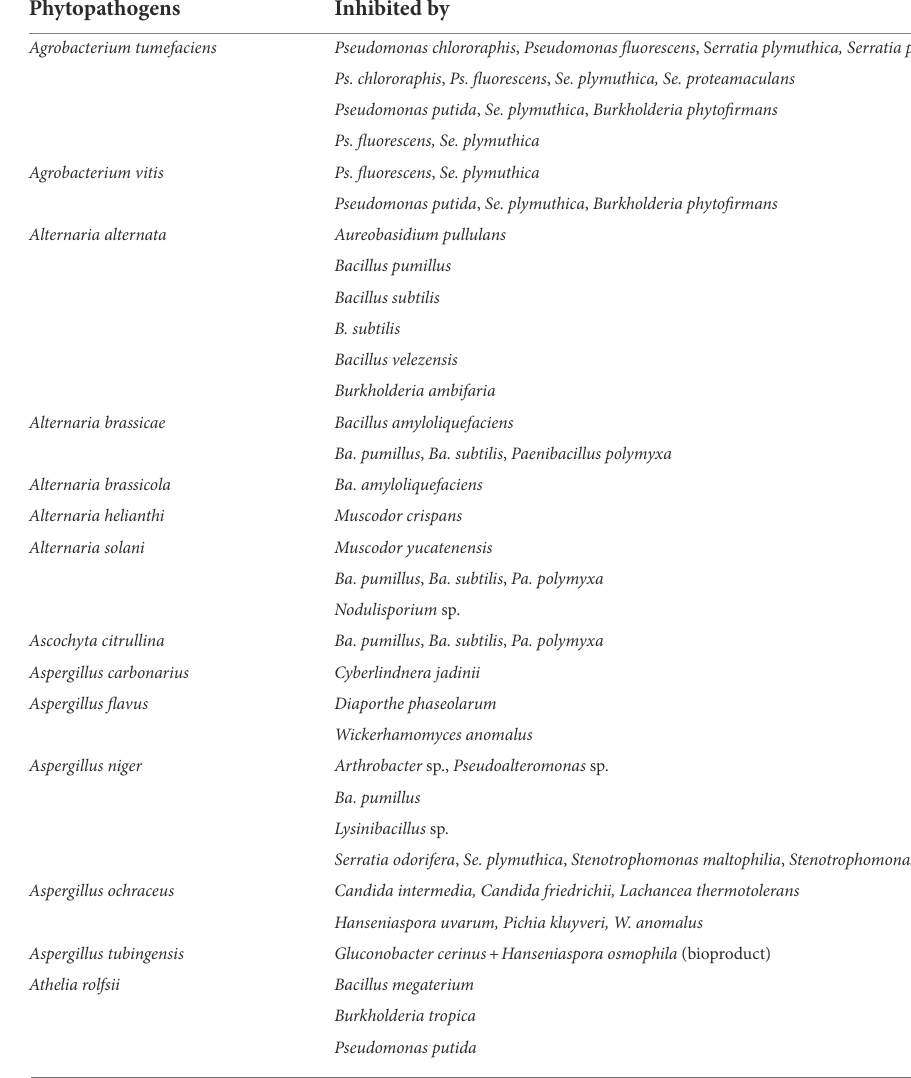
TABLE 1 Phytopathogens inhibited ( in vitro and/or in vivo ) by potential biocontrol